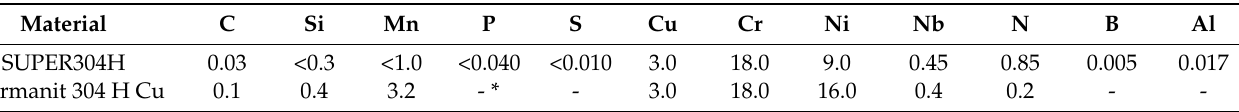
Table 1. Nominal composition (wt. %) of SUPER304H steel and welding filler material Thermanit 304 H Cu